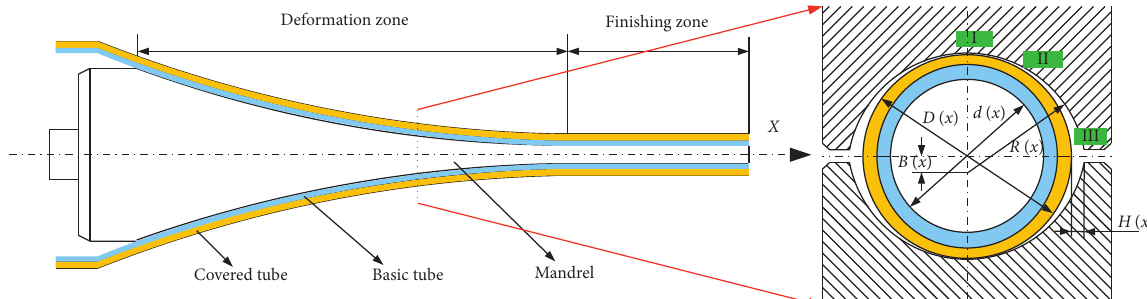
Figure 3: The pilger hot rolling clad tube pass expansion